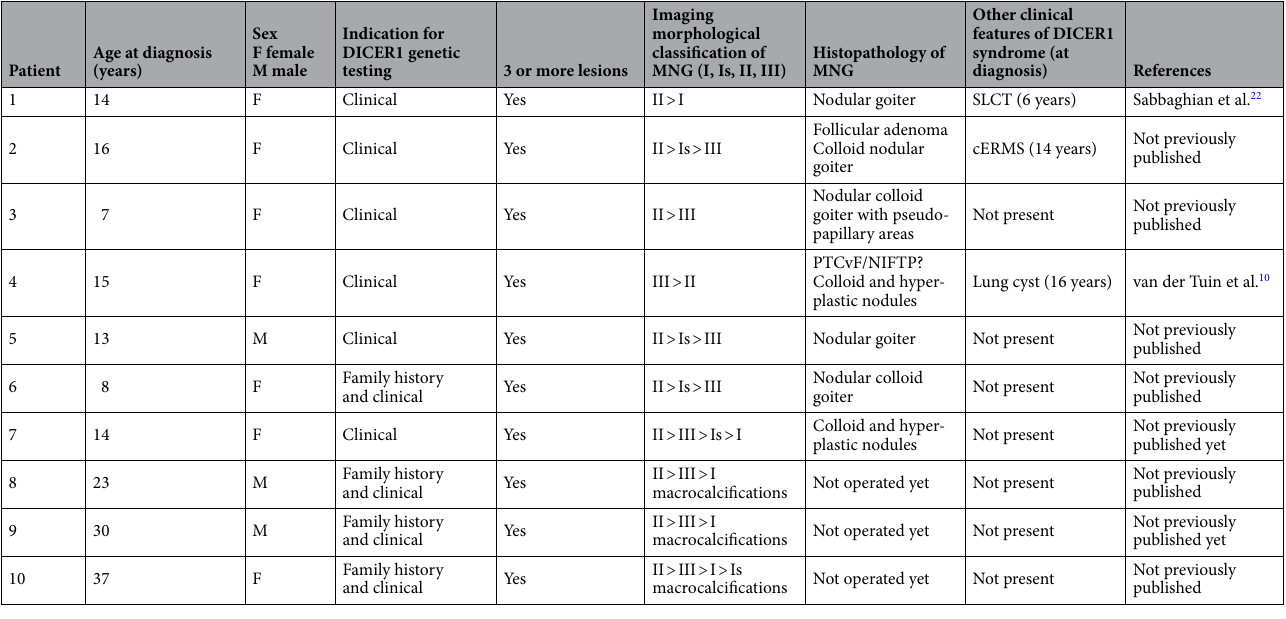
Table 1. The history, clinical, histopathological and imaging characteristics of multinodular goiter (MNG) patients. cERMS cervical embryonal rhabdomyosarcoma, SLCT Sertoli-Leydig cell